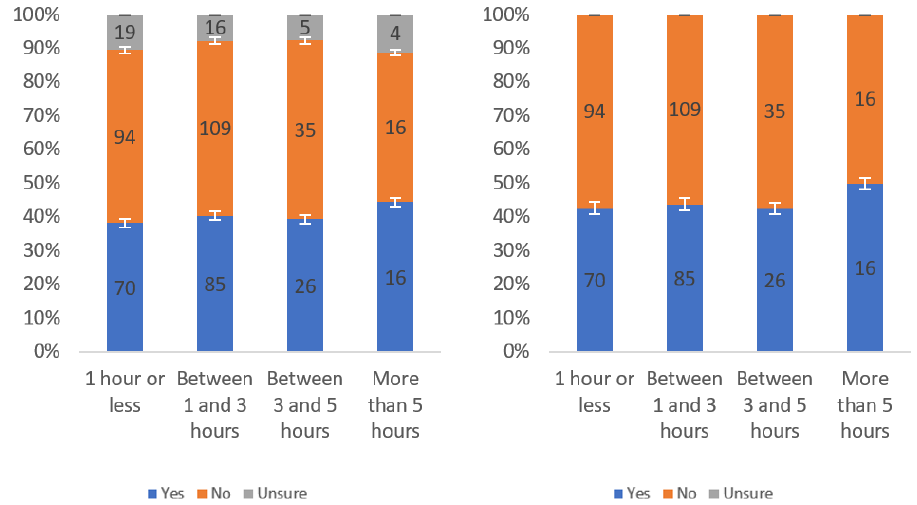
Figure 12. Responses regarding label annoyingness by internet usage level including ( left ) and ex- cluding ( right ) unsure responses.